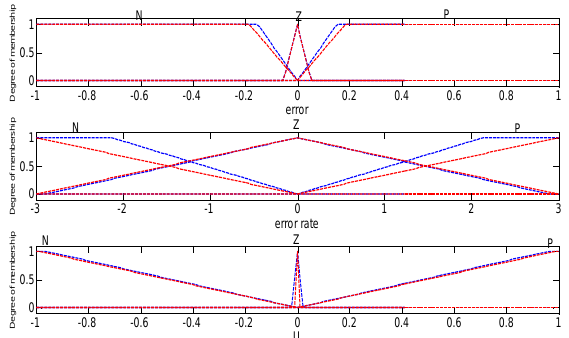
Figure 8. Optimized fuzzy membership functions using GA (blue graph) and PSO (red graph).